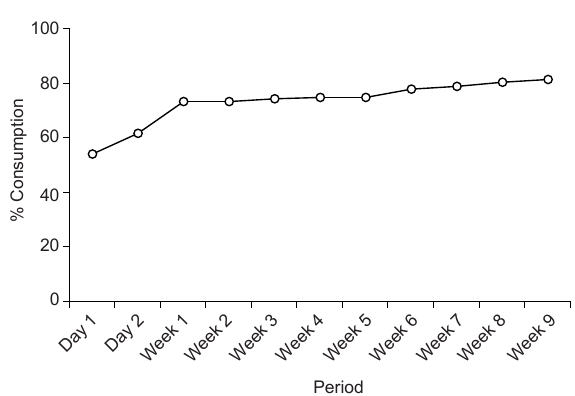
Figure 3. Pattern of food consumption by C. sphinx (n = 15) over nine weeks of